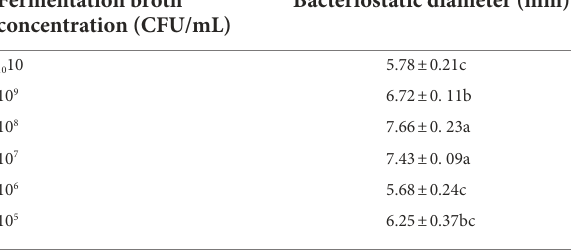
TABLE 5 Antibacterial activity of SDTB038 gradient fermentation broth. Fermentation broth concentration